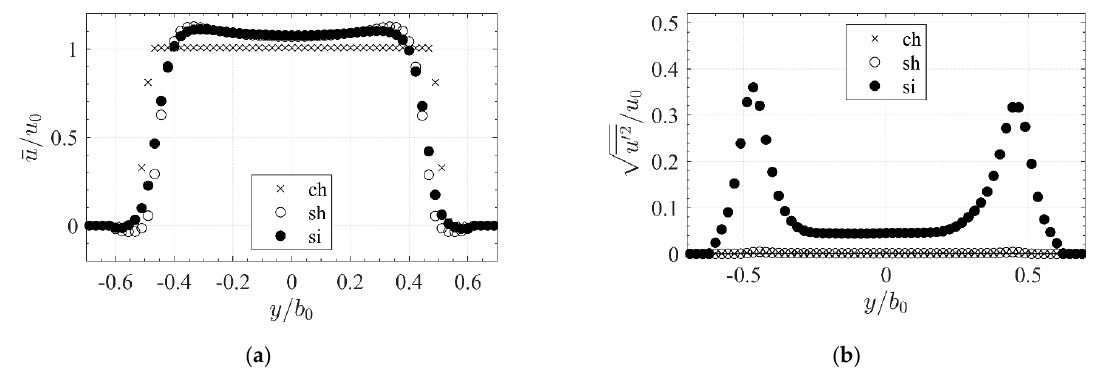
(cid:113) u (cid:48) 2 / u 0